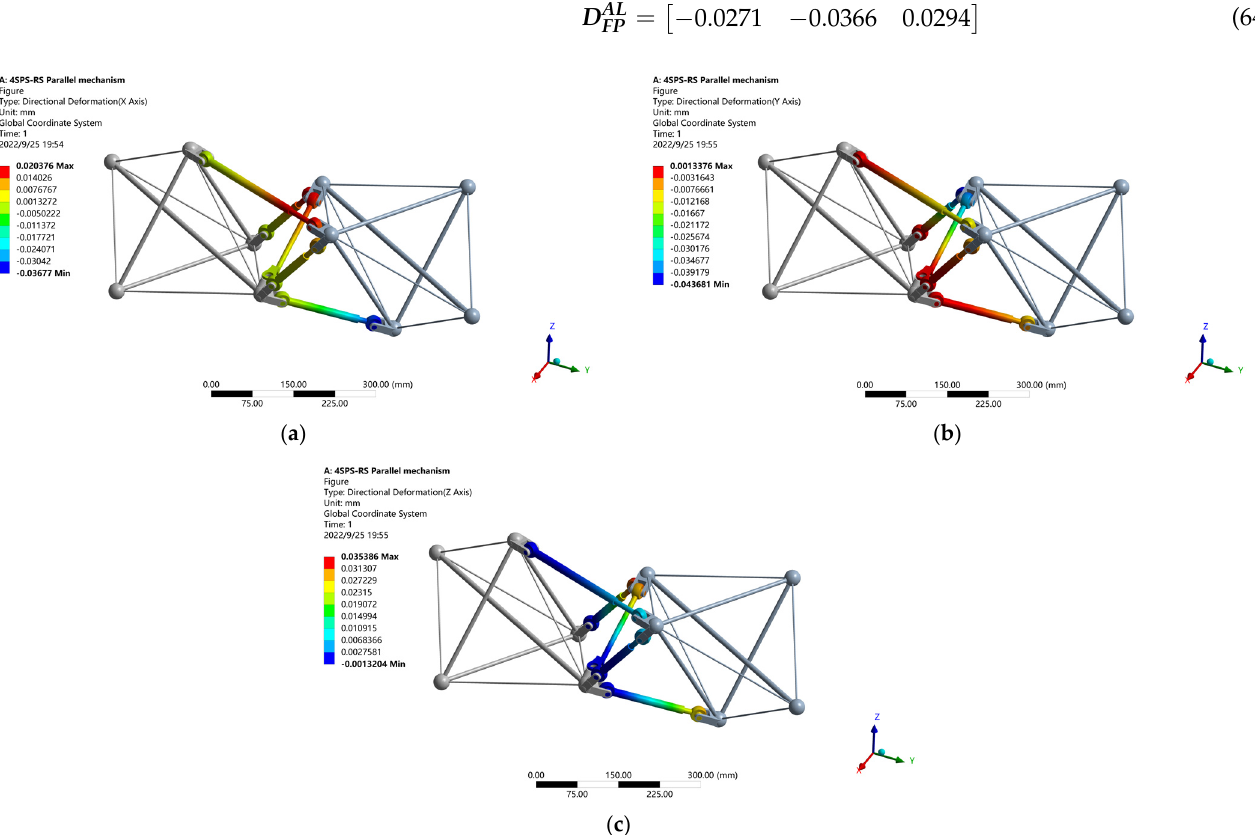
Figure 16. When the external load is the force of 100 N along the z -axis and the material is 7075 aviation aluminum alloy, simulation deformation of 4SPS-RS parallel mechanism in different coordinate directions: ( a ) x -axis; ( b ) y -axis; ( c ) z -axis.